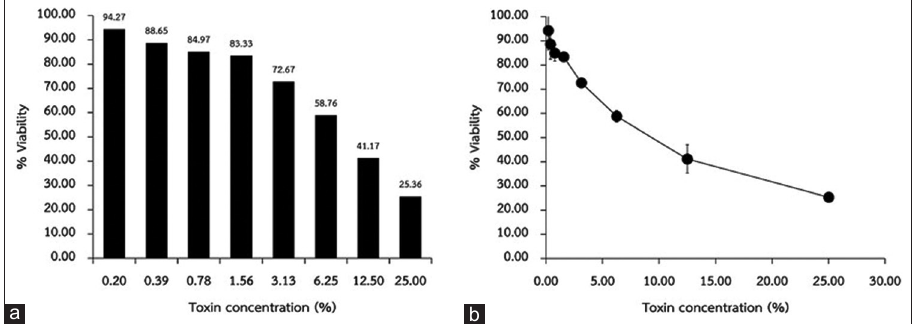
Figure-1: Vero cytotoxicity test of various concentrations of cell-free supernatant E. coli O157:H7 Percentage of cell viability was determined by MTT assay (a) bar graph and (b) line graph.